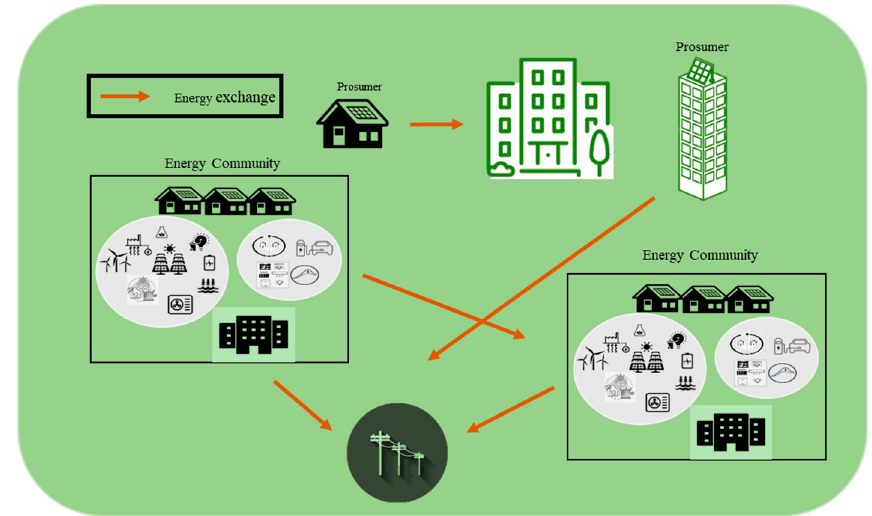
Figure 12. An example of a local energy market within a smart-city.